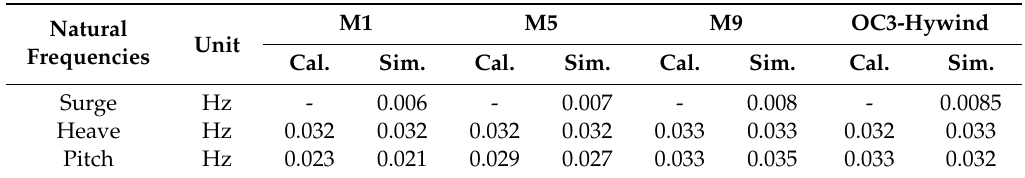
Figure 10. Free decay simulation by FAST, ( a ) surge, ( b ) heave, and ( c ) pitch. Table 6. Comparison of the natural frequencies of the model M1, M5, M9, and OC3-Hywind between spreadsheet calculation and numerical